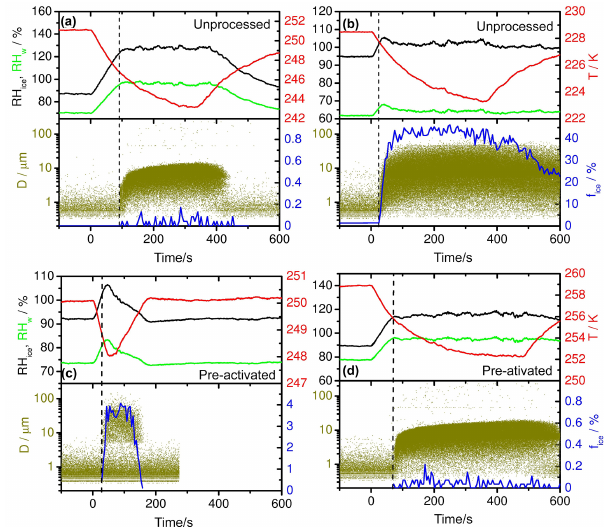
Figure 3. Ice nucleation characteristics of unprocessed (a, b) and pre-activated (c, d) zeolite particles (CBV400) during expansion cooling. Each part shows the relative humidity with respect to ice (black line) and supercooled water (green line), the chamber gas phase temperature (red line), the aerosol and cloud particle size distribution (dark-yellow dots), and the ice-active fraction of the aerosol population (blue